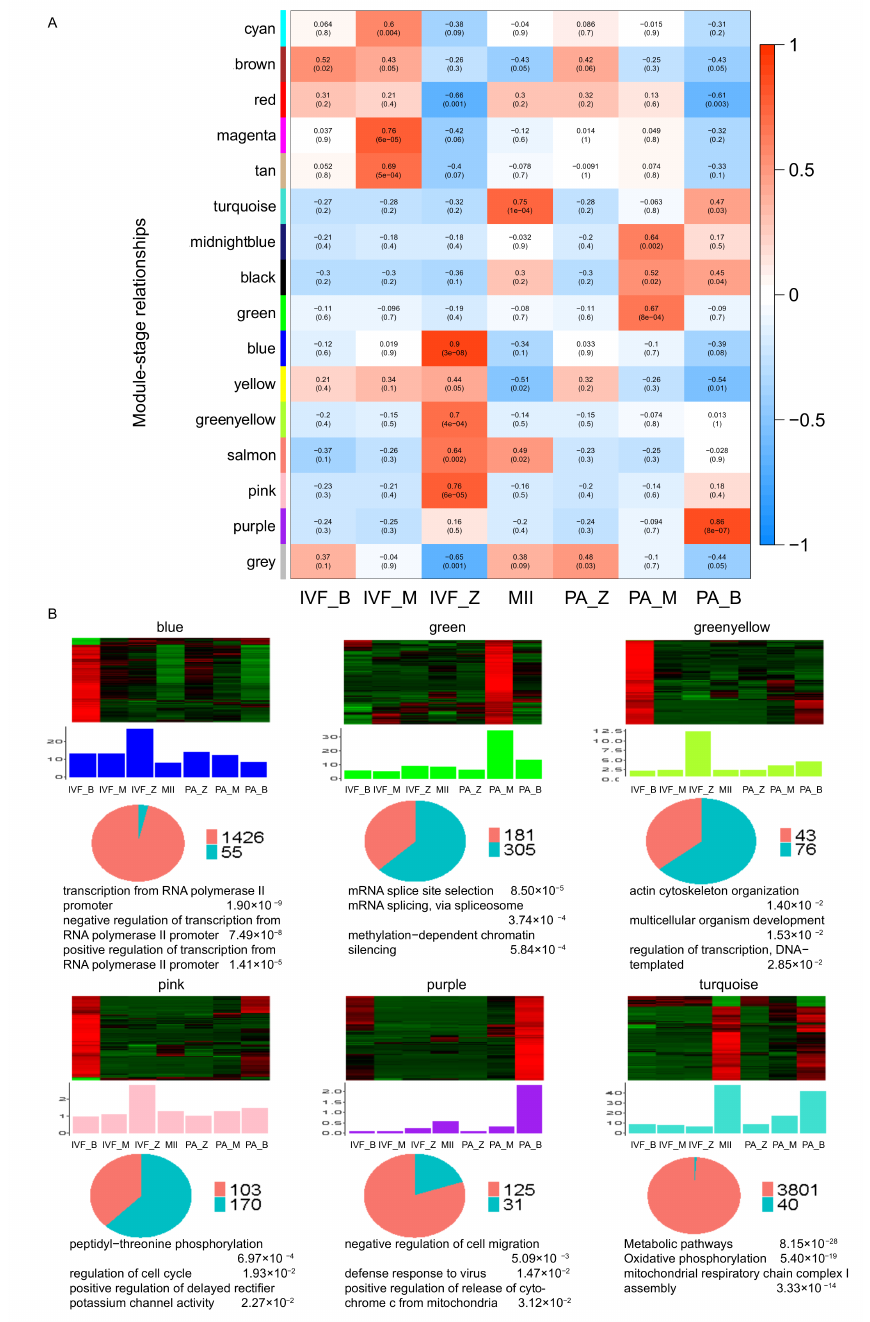
Figure 4. Module-stage correlation analysis and co-expression network analysis of differentially ex- pressed novel lincRNAs and protein-coding genes. ( A ) Module-stage correlations and corresponding p values; on the left, different colors represent different modules; on the right, red indicates positive correlation, white indicates no correlation, blue indicates negative correlation; each cell contains the correlation and p value given in parentheses. ( B ) Co-expression networks of differentially expressed novel lincRNAs and protein-coding genes in six modules; top of each panel: heat maps for expression level of co-expressed genes in six modules. Red, increased expression; green, decreased expression. Middle of each panel: bar plots of the average expression of corresponding module eigengenes. Bottom of each panel: pie charts showing the abundance of lincRNAs and protein-coding genes and top Go terms of the latter within each